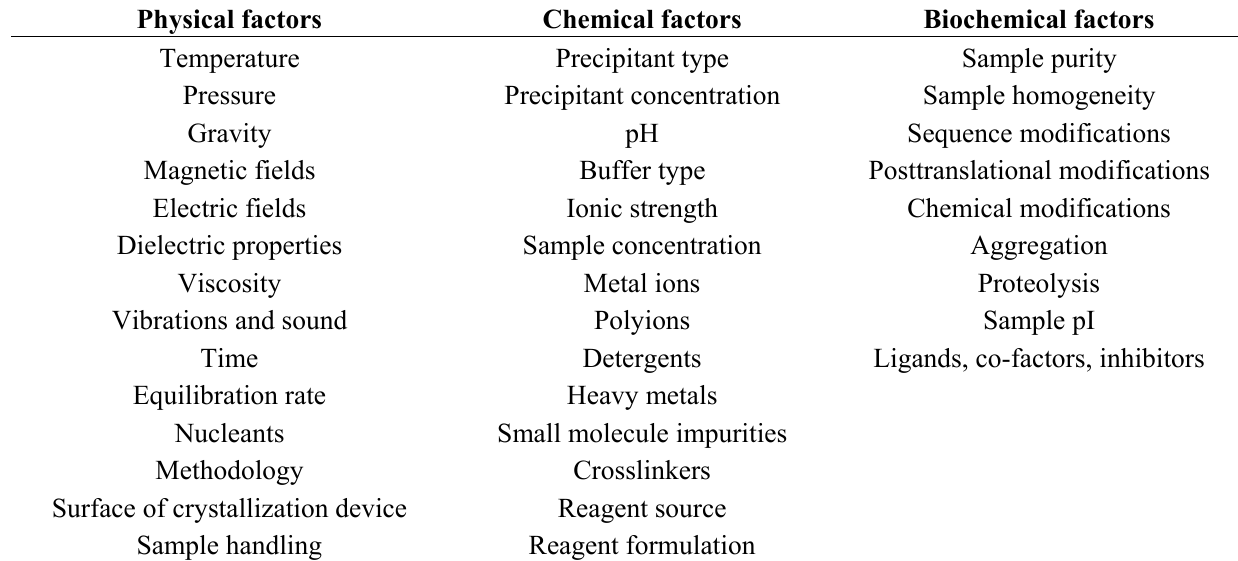
Table 1. Parameters affecting crystallization process